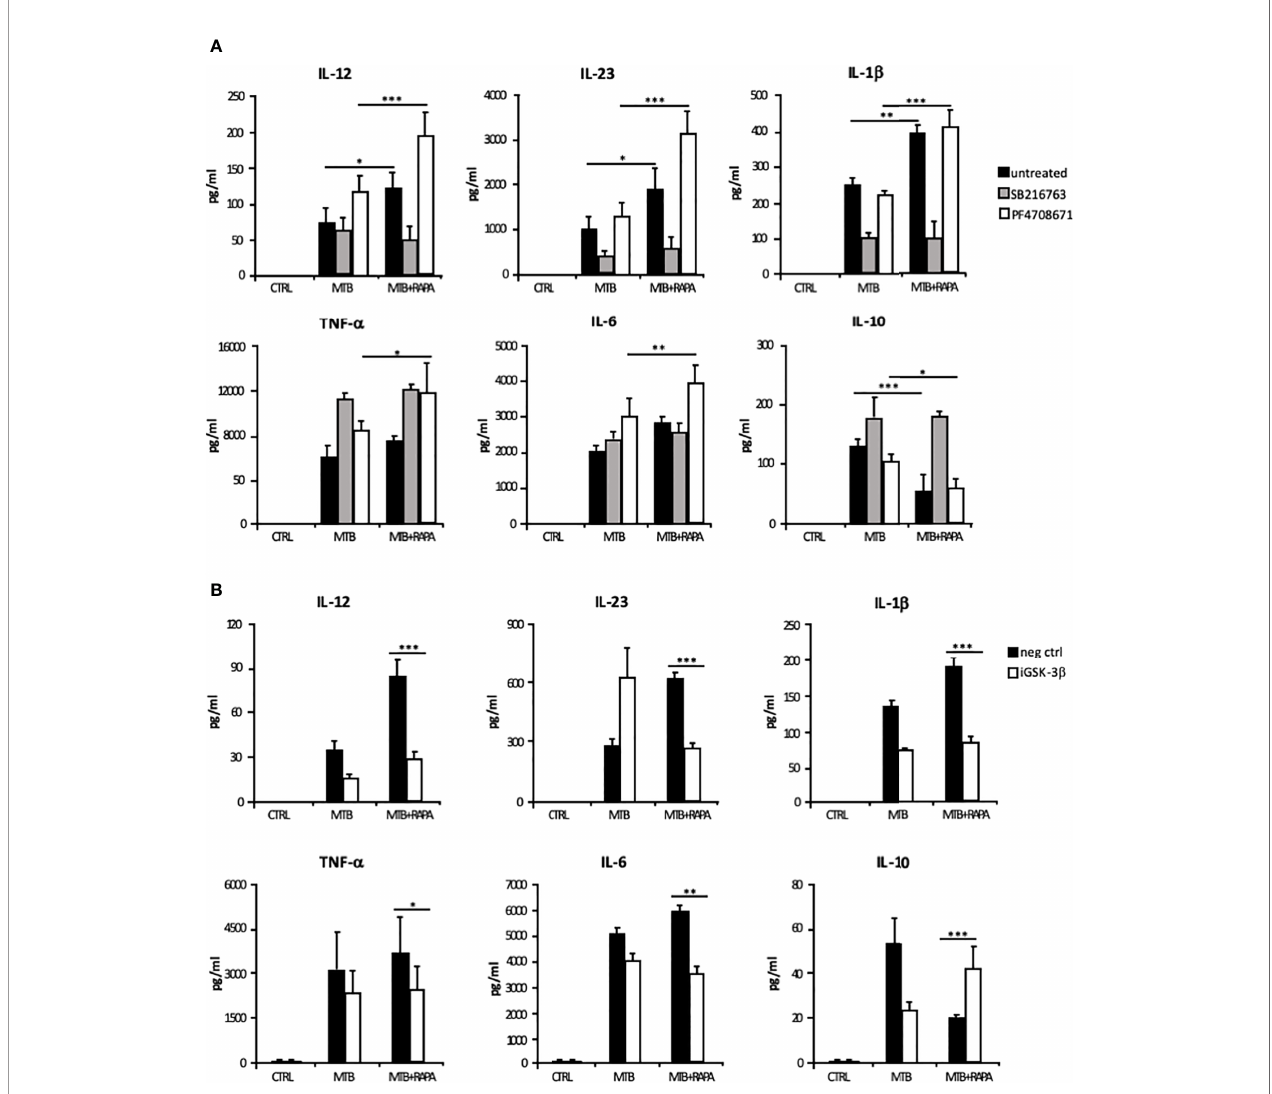
FIGURE 8 | Characterization of GSK-3 b and p70S6K involvement in Mtb-mediated cytokine production during rapamycin treatment of human DC. (A) DC were left unstimulated (CTRL) or infected for 24 h with Mtb alone (MTB) or in combination with rapamycin added 4 h post infection (MTB+RAPA), with or without the GSK-3 b (SB216763) or the p70S6K (PF4708671) inhibitors. IL-12, IL-1 b , TNF- a , IL-6 and IL-10 production was evaluated by In fl ammatory Cytokine bead array kit, while IL- 23 release was measured by ELISA. (B) DC were transfected with 100 nM of siRNA speci fi c for GSK-3 b (iGSK-3 b ) or with a control siRNA (neg ctrl) for 8 h and then left unstimulated (CTRL) or infected for 24 h with Mtb alone or in combination with rapamycin. Cytokine amount was determined as in (A) . The results represent mean values ± standard error of 4 independent experiments. Signi fi cance was calculated by analysis of variance (ANOVA) followed by multiple comparison performed with Tukey ’ s test as speci fi ed in Materials and Methods